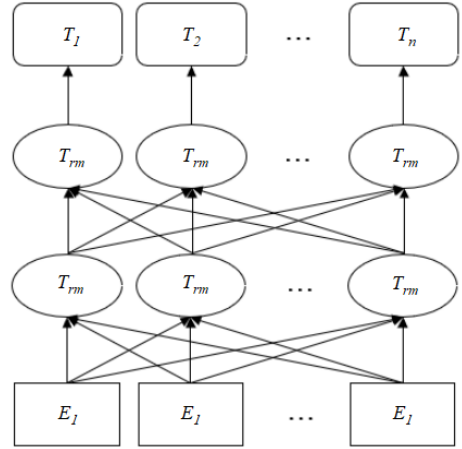
Figure 4. BERT pre-trained language model structure.